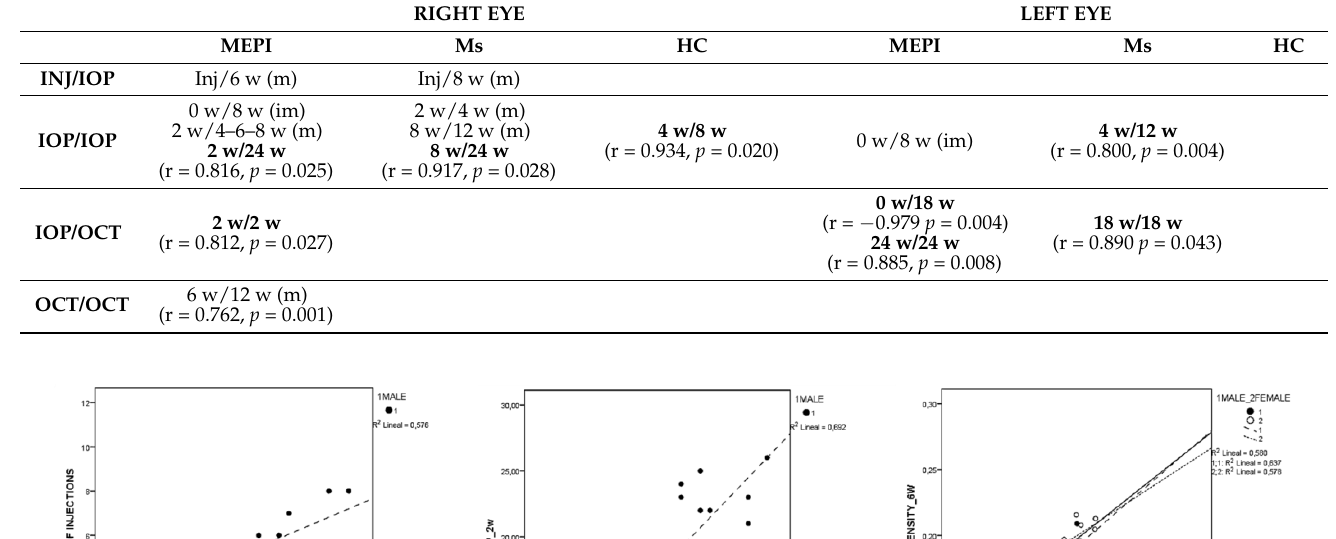
Table 1. Correlations in both chronic glaucoma models and healthy controls. Abbreviations: INJ: injections; IOP: intraocular pressure; OCT: optical coherence tomography; w: week; RE: right eyes; LE: left eyes; MEPI: model induced by sclerosing the episcleral veins; Ms: model induced by injecting microspheres into the anterior chamber; HC: healthy controls; im: inverse moderate correlation; m: moderate correlation. In bold: statistically high correlations.